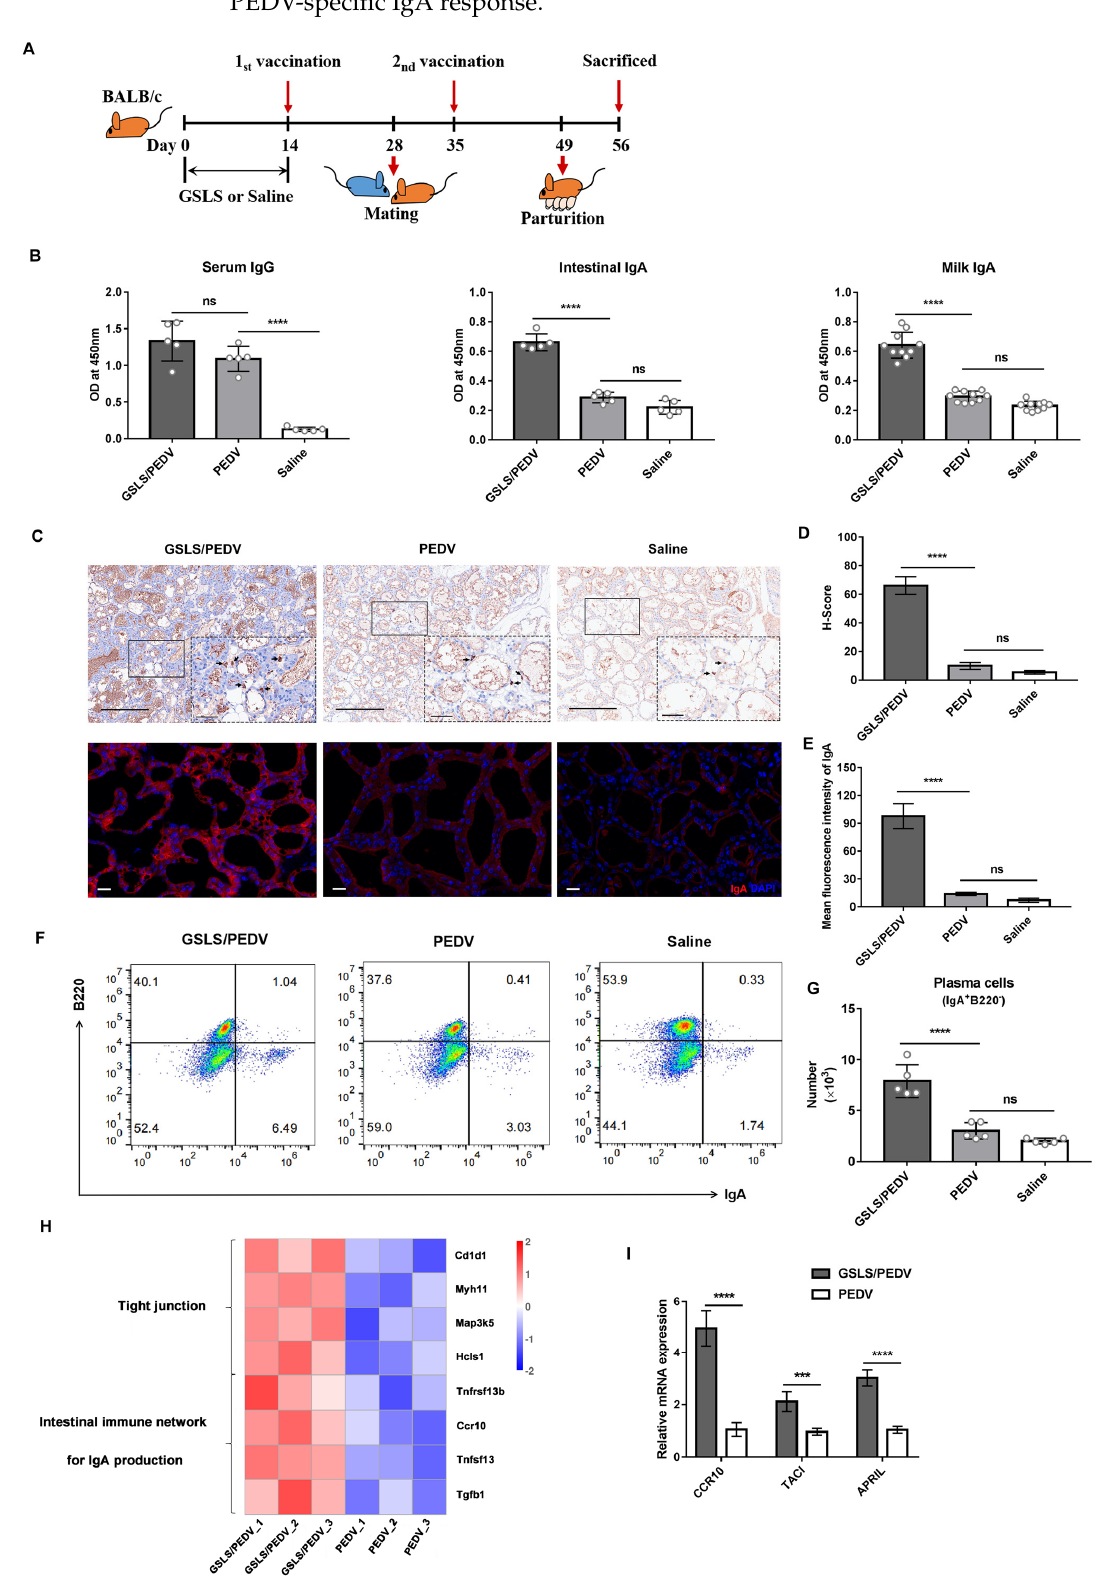
Figure 1. GSLS enhance the maternal IgA antibody response to a PEDV inactivated vaccine. Female BALB/c mice ( n = 5/group) were gavaged daily with GSLS (5 mg/kg/day) or saline for 2